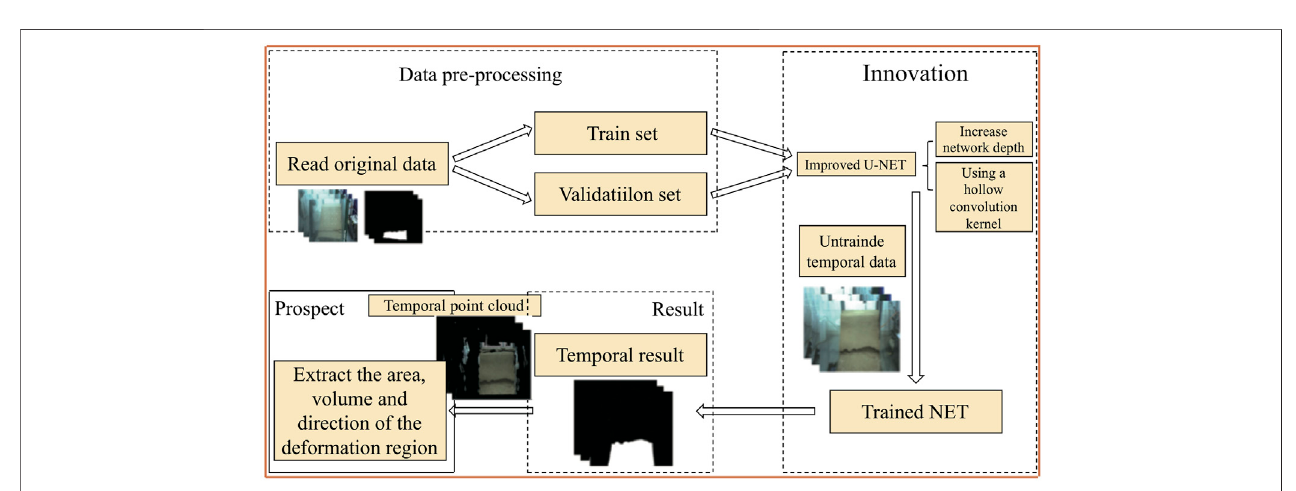
FIGURE 2 | The fl ow chart of time sequence information extraction of landslide deformation area.